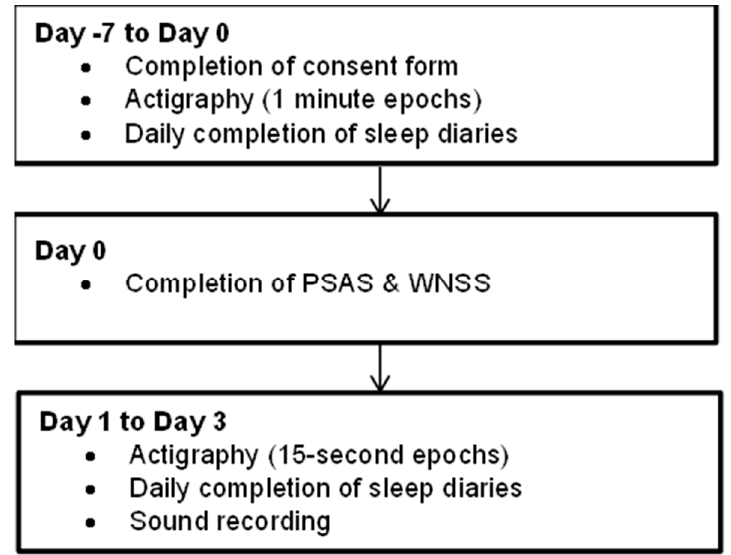
Figure 1. Study schematic .